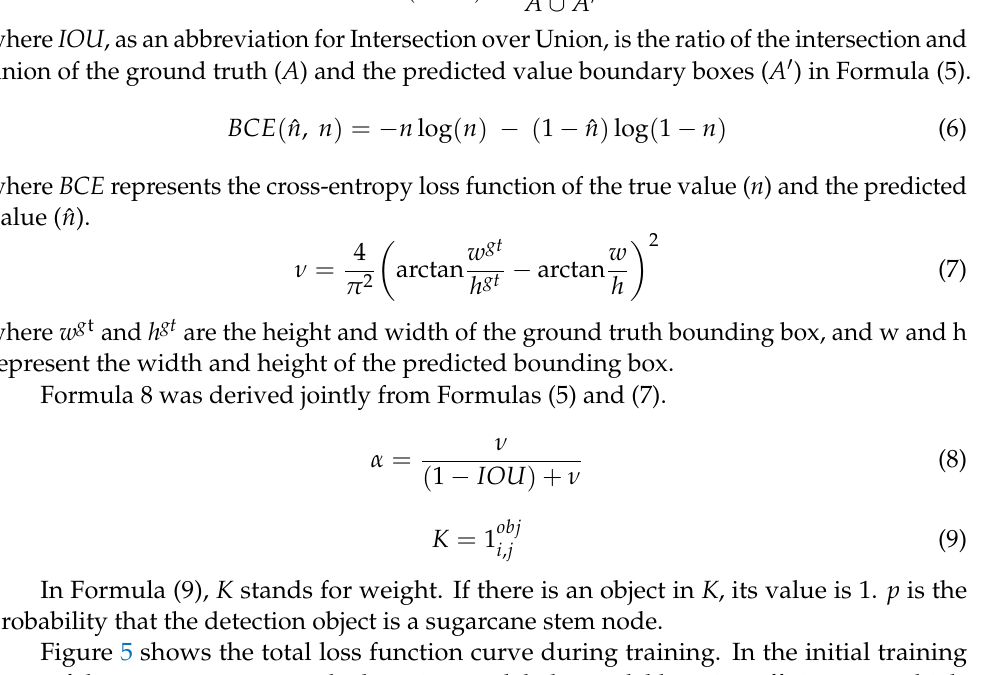
Formulas (3) and (4).